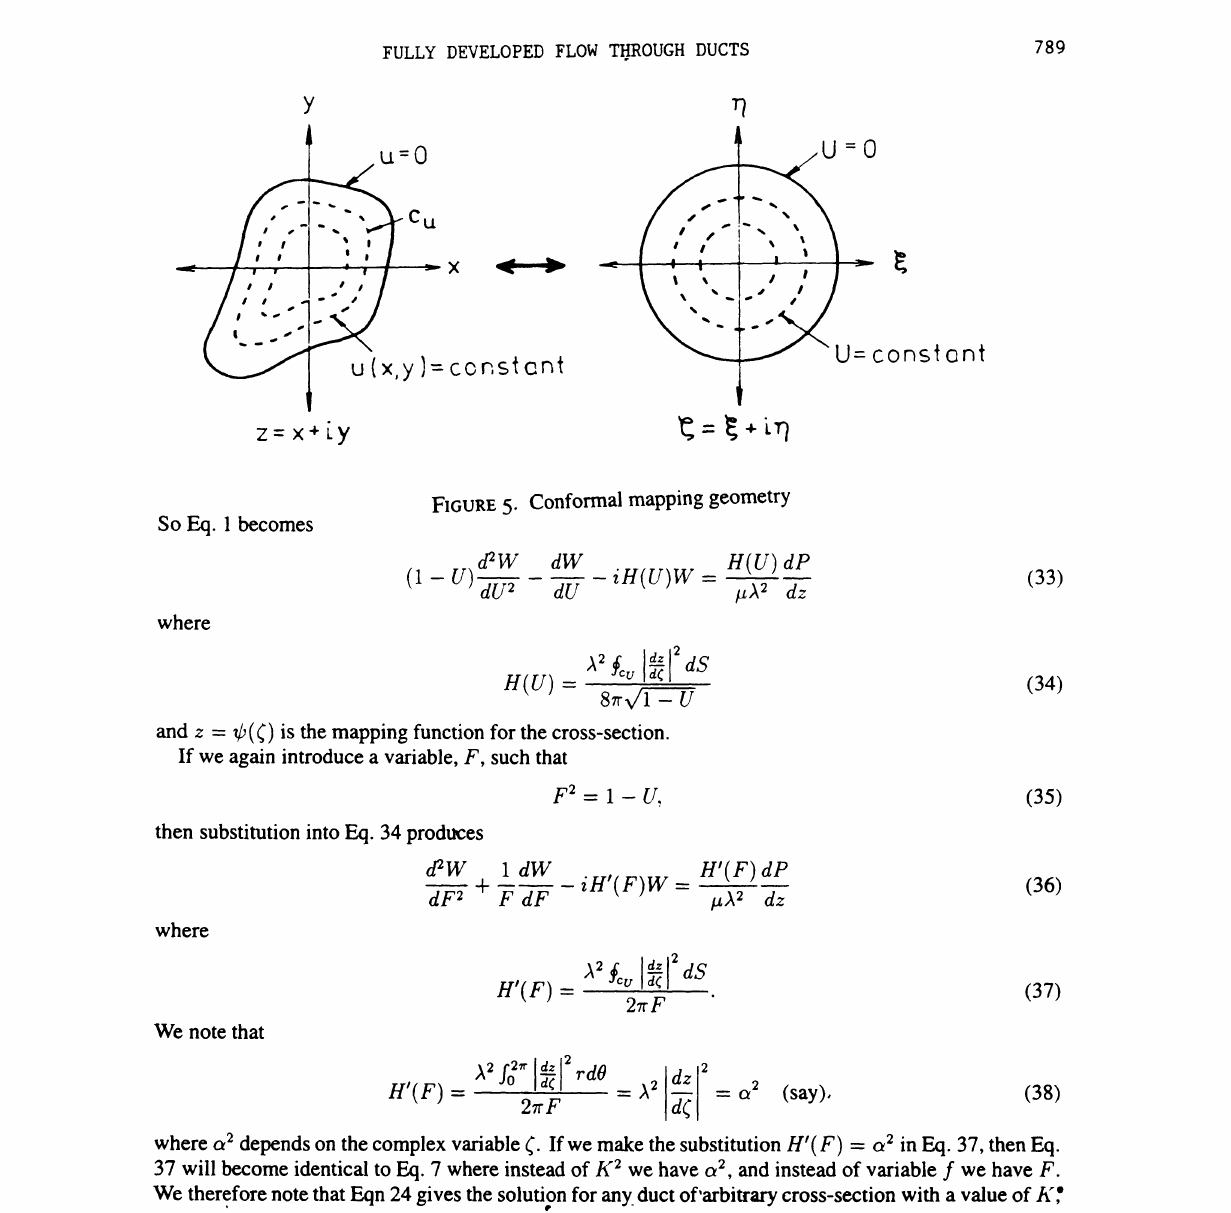
FIGURE 5. Conformal mapping geometry